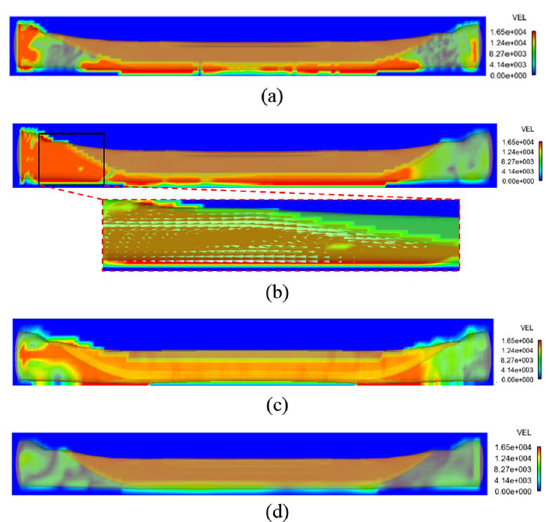
Figure 33 Cloud maps of fluid velocity during hydraulic bulging closing: ( a ) Cloud map of fluid velocity at 0.25 s, ( b ) Cloud map of fluid velocity at 0.28 s, ( c ) Cloud map of fluid velocity at 0.32 s, ( d ) Cloud map of fluid velocity at 0.40 s